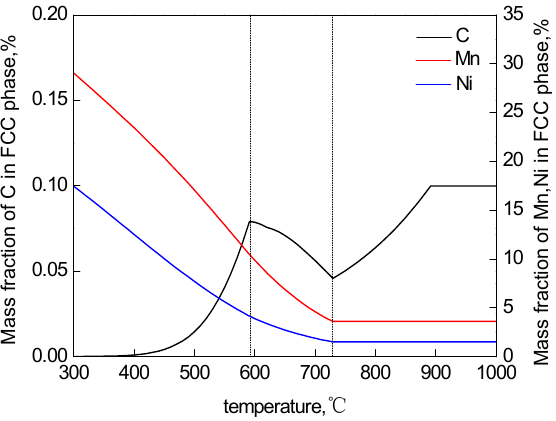
Figure 10. Mass fraction of C, Mn and Ni in γ at different temperatures calculated by Thermo-Calc. With an increase of TT, the proportion of austenite gradually increases (Figure 9), but the content of Mn and Ni gradually decreases (Figure 10). Until the TT is higher than A e3 , the matrix is completely transformed into the austenite phase, and the content of manganese and nickel reaches an equilibrium state. With an increase of the TT, the C mass fraction in the austenite phase has three inflection points. The first point at 600 °C is mainly due to the dissolution of the cementite phase, the second point of C mass fraction where the ferrite phase is completely transformed into the austenite phase is of a minimal value, and the third point shows that the VC phase is completely dissolved in austenite. Before the first point, the variation in the C mass fraction in the austenite phase is mainly affected by the cementite phase [28]. Between the first point and the second point, the C mass